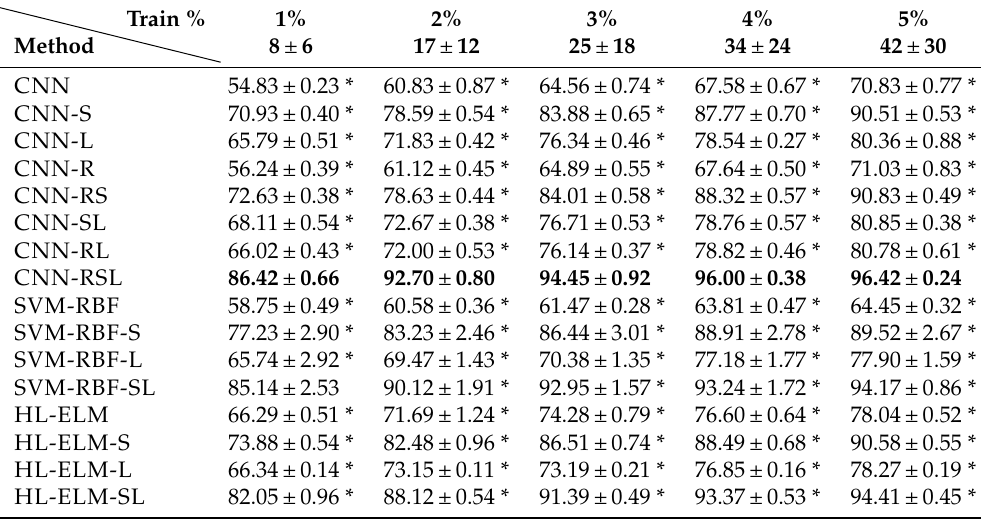
Table 6. Test set classification accuracy on the Indian Pines dataset, when using 1–5% randomly sampled labeled pixels per class for training. We report the mean and standard deviation over 10 runs. We also list the mean and standard deviation of the number of training pixels per class for each training %. The best accuracy for each training set is indicated in bold. An ‘*’ means that the best accuracy is significantly better than the accuracy achieved by the corresponding method according to a binomial test for comparing classifiers [45] ( p -value <